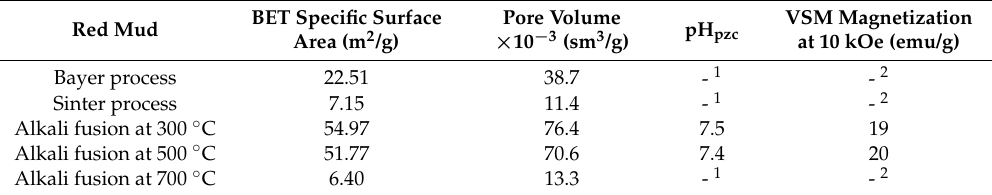
Table 3. The chemical composition of red muds.